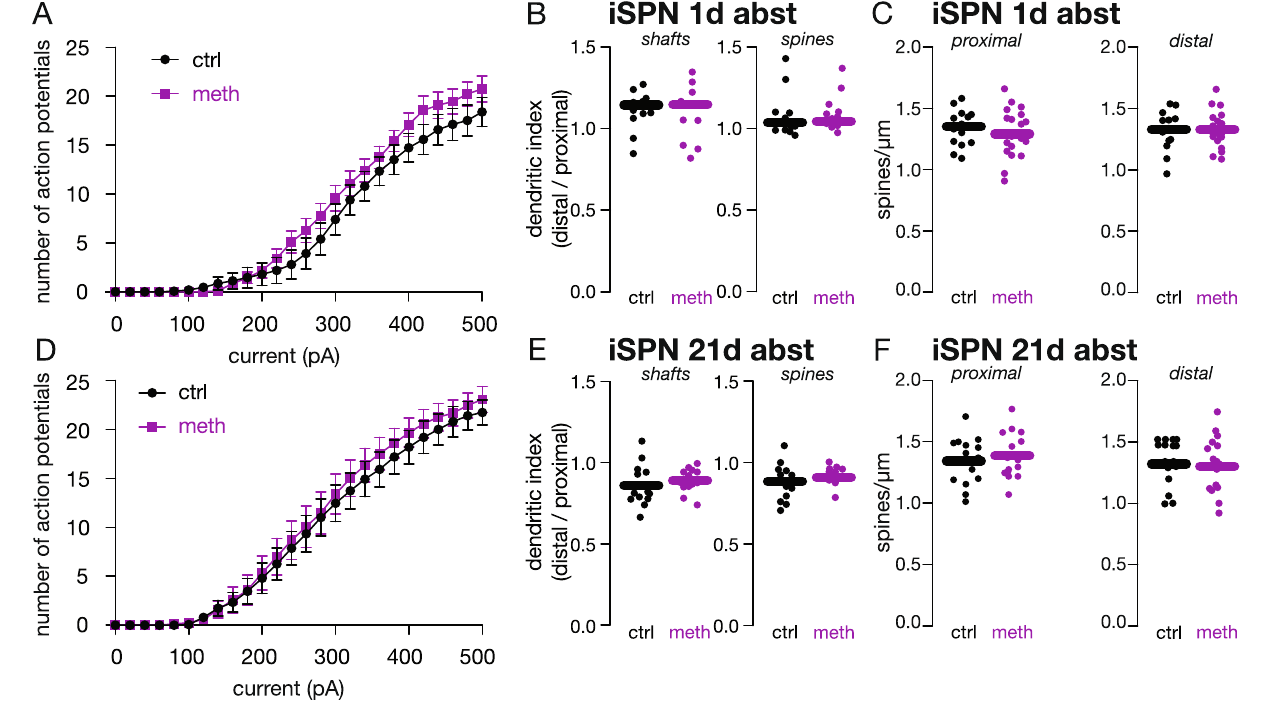
Figure 3. Repeated meth administration had no effect on DLS iSPN excitability or spine density after acute or protracted abstinence. ( A ) Repeated meth had no effect on DLS iSPN intrinsic excitability when measured during acute (1 day) abstinence (ctrl n = 15 neurons/5 mice, meth n = 21 neurons/11 mice). Two-way ANOVA showed significant effect of current (F (25,400) = 210.2, p < 0.0001) but not treatment (F (1,16) = 0.0323, p = 0.8596) or current X treatment interaction (F (25,348) = 0.5678, p = 0.9549). ( B ) Repeated meth had no effect on DLS iSPN dendritic excitability when measured during acute abstinence; sample sizes are identical with those in Fig. 3A. Data analyzed using unpaired t - or Mann–Whitney tests as appropriate (shaft t (31) = 1.203, p = 0.2379, two- tailed; spine U = 126.5, p = 0.9629, two-tailed). ( C ) DLS iSPN spine density was unchanged after 1 day abstinence (ctrl n = 15 neurons/5 mice, meth n = 17 neurons/11 mice). Data analyzed using unpaired t -tests (proximal: t (31) = 0.5801, p = 0.5661, two-tailed; distal: t (30) = 0.3909, p = 0.6986, two-tailed). ( D ) DLS iSPN intrinsic excitability was unchanged after protracted (21 day) abstinence from repeated meth (ctrl n = 15 neurons/6 mice, meth n = 15 neurons/5 mice). The two-way ANOVA showed significant effect of current (F (25,350) = 186.4, p < 0.0001) but not treatment (F (1,14) = 0.1897, p = 0.6698) or current X treatment interaction (F (25,350) = 0.2308, p > 0.9999). ( E ) Meth had no effect on DLS iSPN dendritic excitability after protracted abstinence; sample sizes are identical to Fig. 3D. Data analyzed using unpaired t -tests (shaft: t (25) = 0.7649, p = 0.4515, two-tailed; spine: t (25) = 1.135, p = 0.2670, two-tailed). ( F ) Protracted abstinence from repeated meth did not alter DLS iSPN spine density (ctrl n = 16 neurons/6 mice, meth n = 15 neurons/5 mice). Data analyzed using unpaired t -tests (proximal: t (29) = 0.0975, p = 0.9230, two-tailed; distal: t (29) = 0.6713, 0.5073,